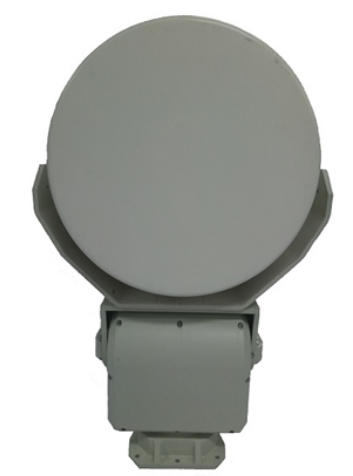
Figure 6. The proposed FOD millimeter-wave surveillance